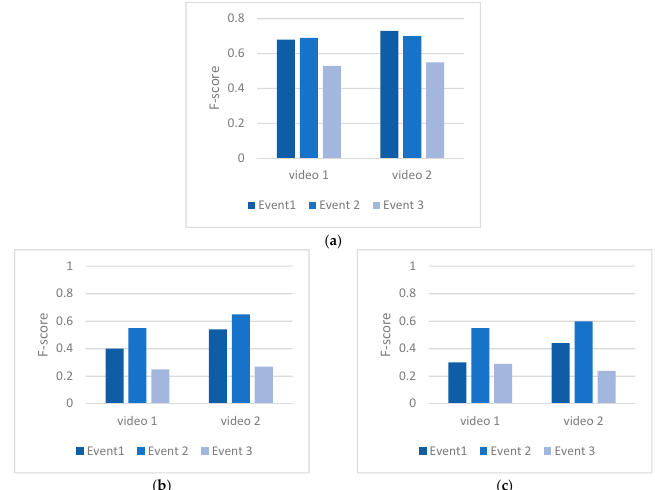
Figure A1. Event matching results. ( a ) The integrated designed architecture event detection results. ( b ) The single-camera edge-based architecture results for Camera1. ( c ) The single-camera edge-based architecture results for Camera2. Event 1 is coughing into hands and touching the door handle; Event 2 is coughing into arms and touching the door handle; Event 3 is coughing into hands, and/or arms, and touching the door handle.